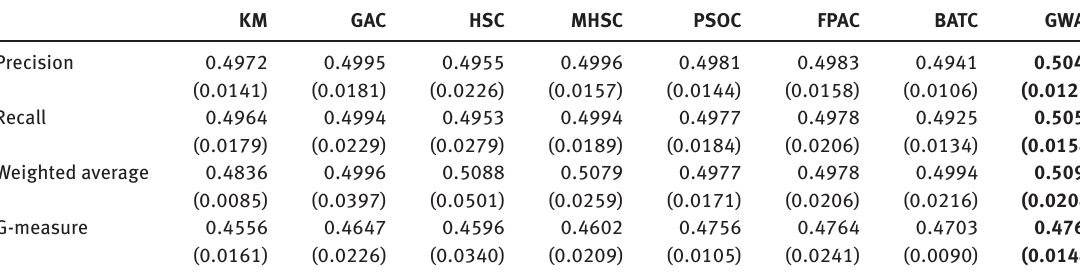
Table 8: Mean (SD) of Cluster Quality Matrices for Haberman Data Set.